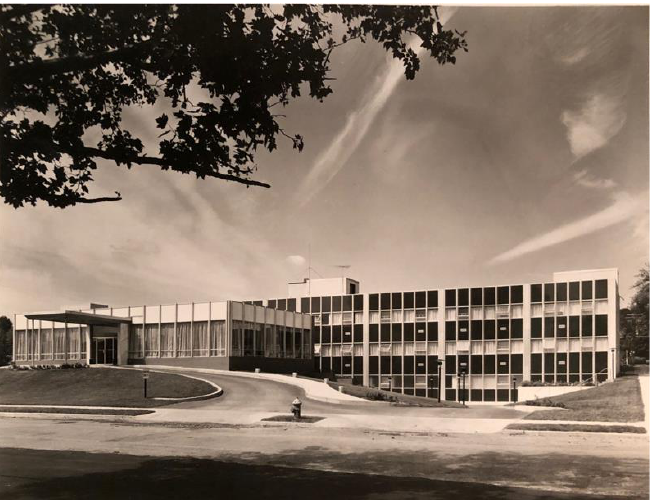
Figure 19. Doctors Hospital, 1963. Source: Linda Bohm’s personal archive.